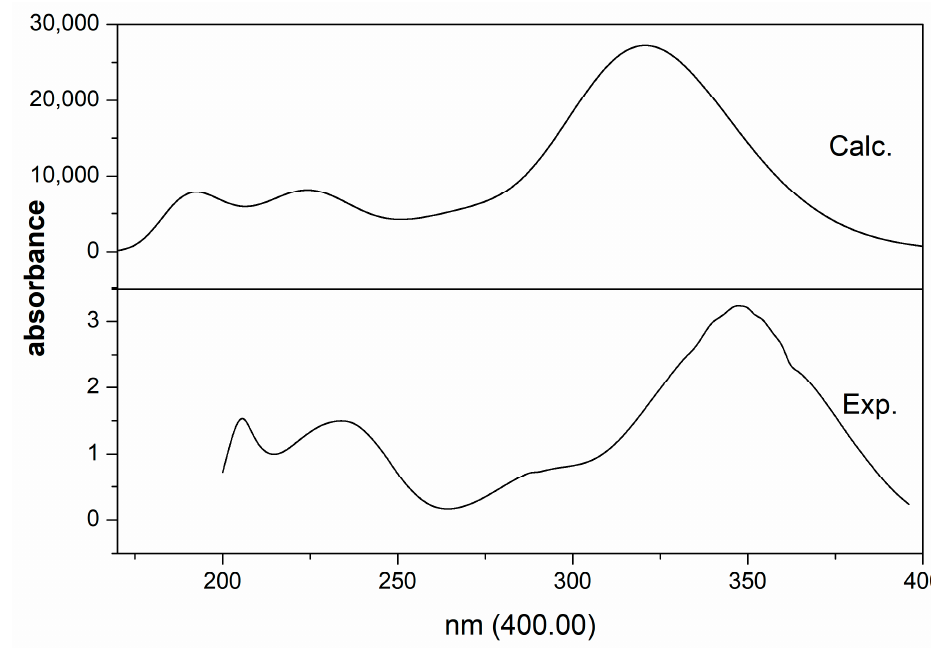
Figure 5. Experimental and calculated UV − Vis spectra for HMD. Table 4. Experimental and calculated electronic transition parameters for HMD. Exp.